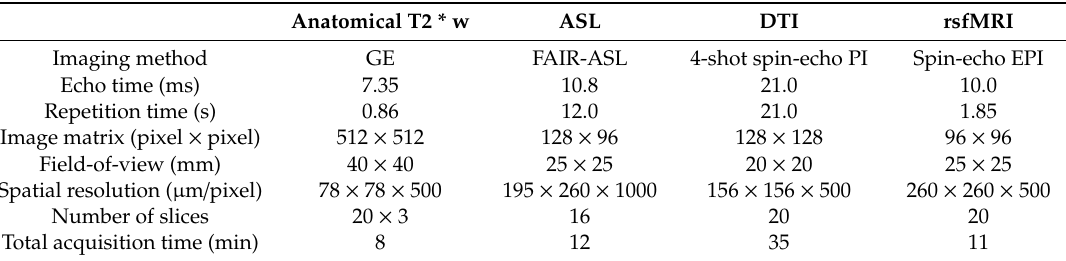
Table 2. Imaging parameters.